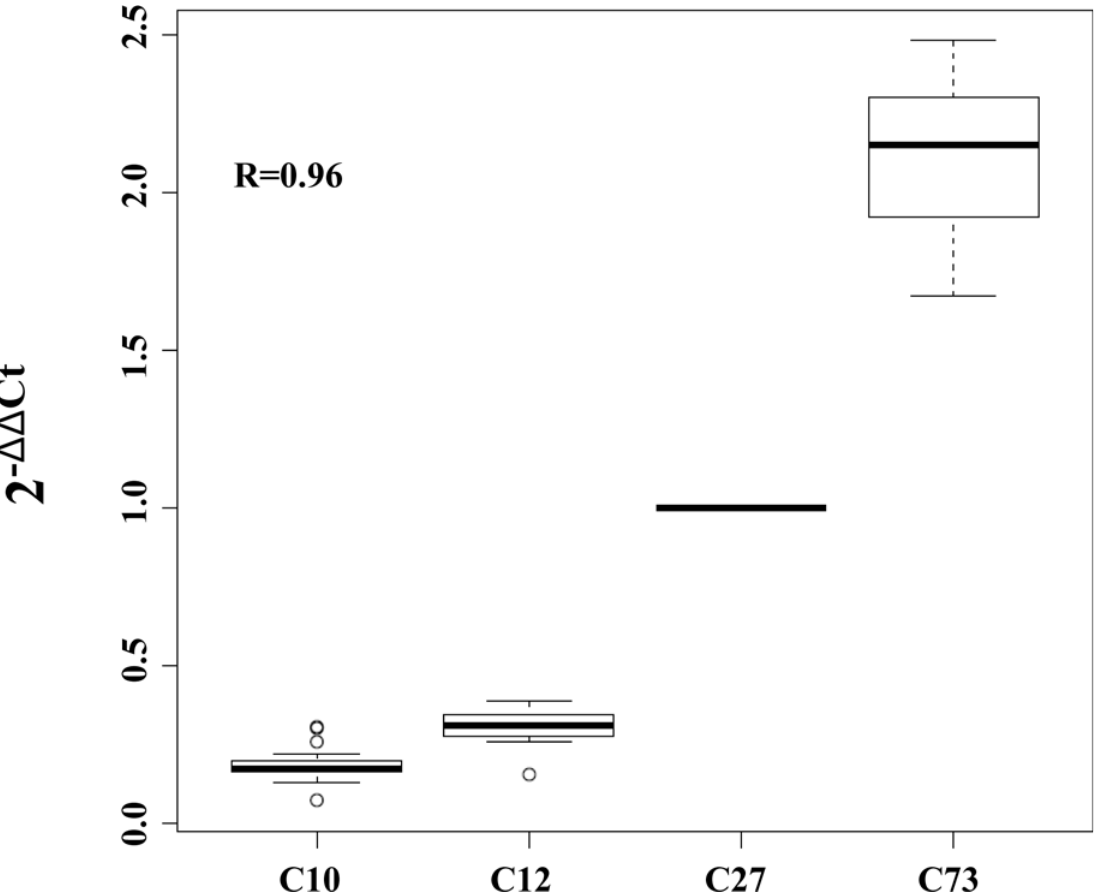
Fig 1. Correlation between ΔΔ Ct and absolute number of DNA copies of LPA exon 4. The C27 sample, previously predicted to have 27 DNA copies of this region, has been used as reference.